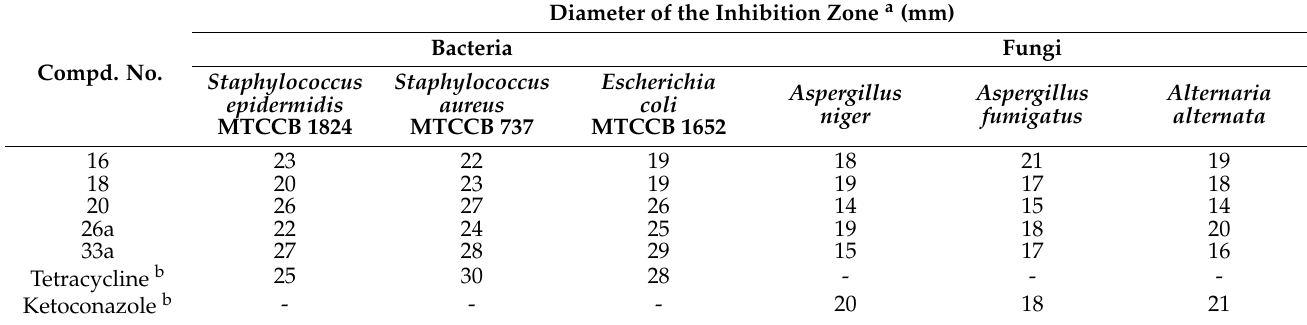
Table 1. Antimicrobial activity of the synthesized compounds at 100 mg/mL concentration.